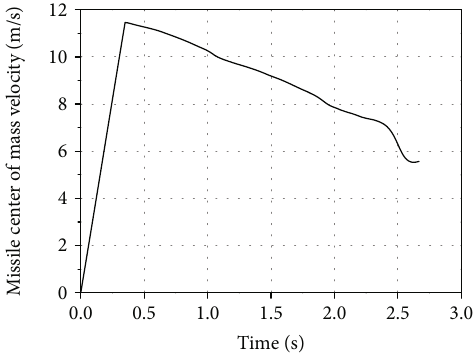
Figure 17: Missile centroid velocity under the fl uctuating platform. Figure 18: The pitch angle of the missile under the fl uctuating platform.